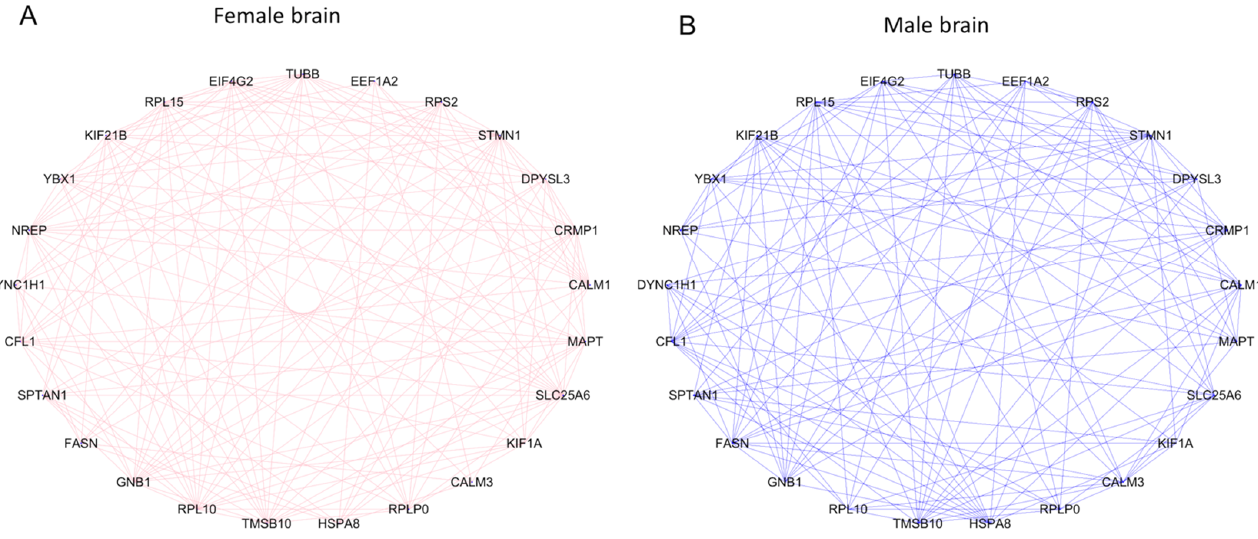
Figure 6. Violin plots of e×pression of marker genes specific to neurons ( A ) and astrocytes ( B ) of male (light blue) and female brain (pink) developing during GD45 to GD60 and GD60 to GD90. In both plots, the values in y-a×is represent the log fold changes of gene e×pression. The ×-a×is shows the sample comparisons. 4. Discussion It is known that the rate of growth of male and female fetuses vary throughout ges- tation [59]. Birth weight is generally higher in male than female piglets [60]. Sex-mediated differences in growth is well documented in other animals including humans [61–64]. Our current study showed fewer numbers of DEGs in the fetal brain during GD45 vs. GD60 compared to GD60 vs. GD90 developmental period. There was a ~3.5-fold increase in the number of genes that altered between GD60 and GD90 compared to GD45 and GD60 (Ta- ble 1). This finding implied that gene expression changed extensively in the fetal brain